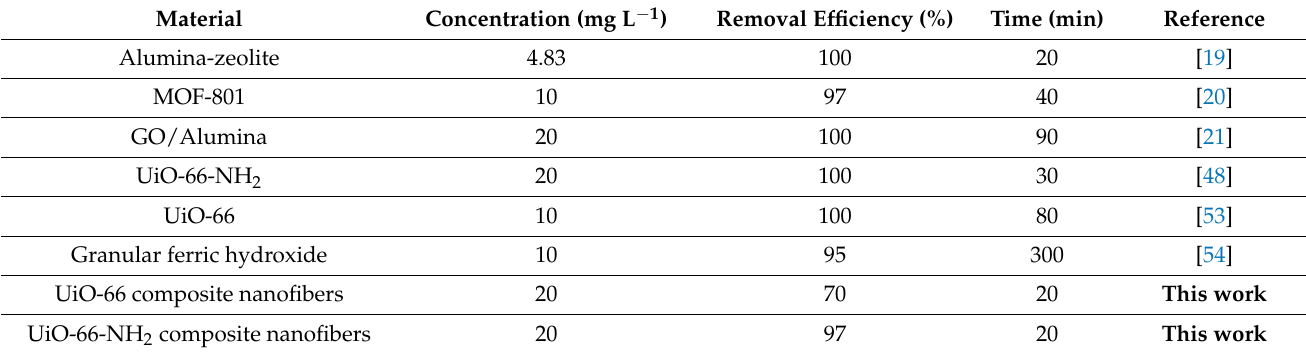
Table 2. Comparison of the fluoride removal performance with other reported